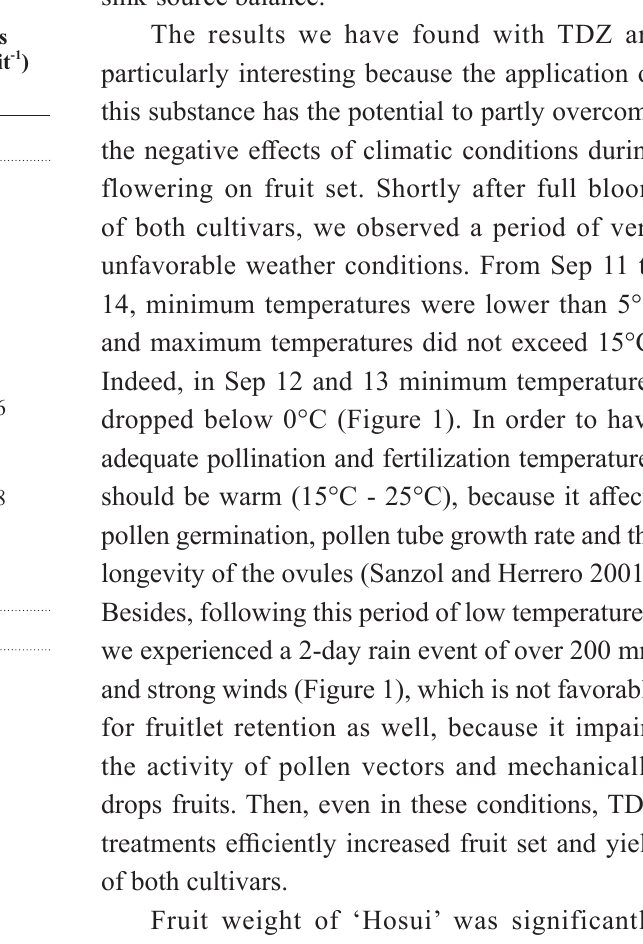
The effect of thidiazuron (TDZ) and aminoethoxyvinylglycine (AVG) on fruit quality of ‘Hosui’ and ‘Packham’s Triumph’